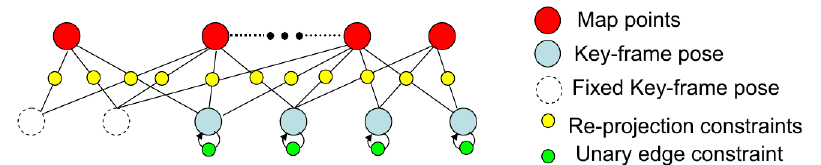
Figure 5. Factor graph for long-range stereo local bundle adjustment.